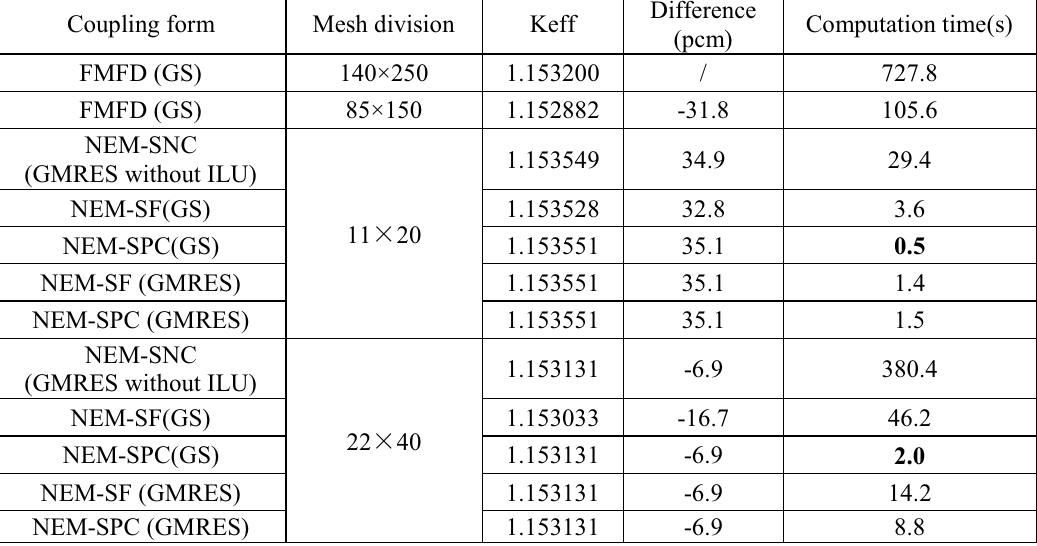
Table II. Calculation results of case 2 (with